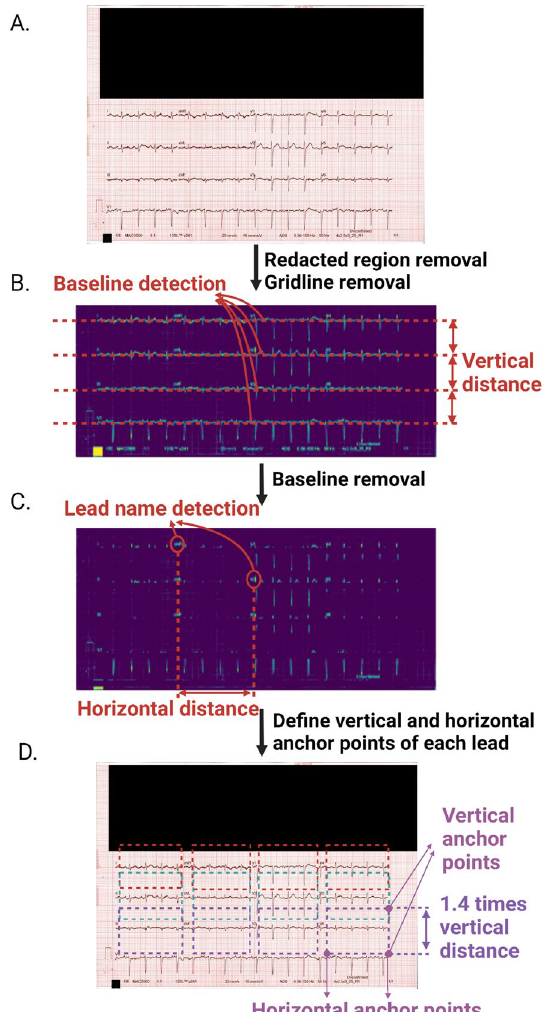
Figure 2. Cropping of individual ECG signal images for each lead: ( A ) The original 12-lead ECG scan with patient identifiable information redacted; ( B ) Baseline detection is used to determine the vertical distance between leads; ( C ) Lead name detection are used to determine the horizontal distance between leads; ( D ) Cropping to obtain each lead’s ECG signal. The width of the crop is the distance from end point of the lead name to the starting point of the adjacent lead name, while the height of the crop is 1.4 times of the vertical distance with the detected baseline in the